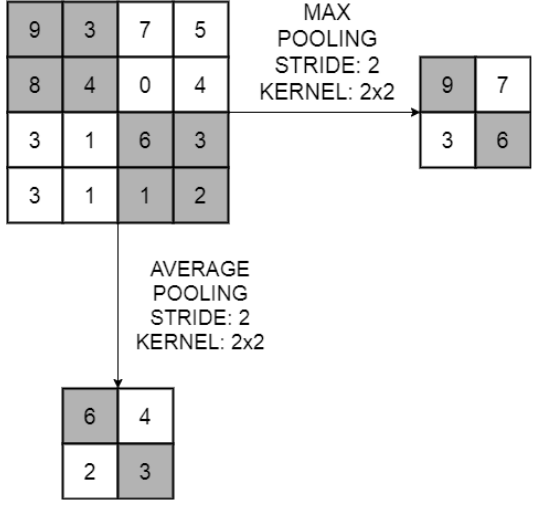
Figure 4. Max pooling and average pooling